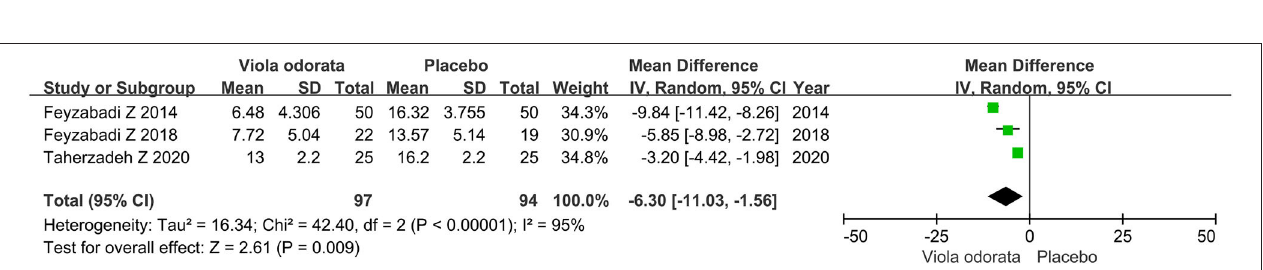
FIGURE 6 | Forest plots showing results in ISI score. ISI, insomnia severity index; SD, standard deviation; IV, inverse variance; df, degrees of freedom.